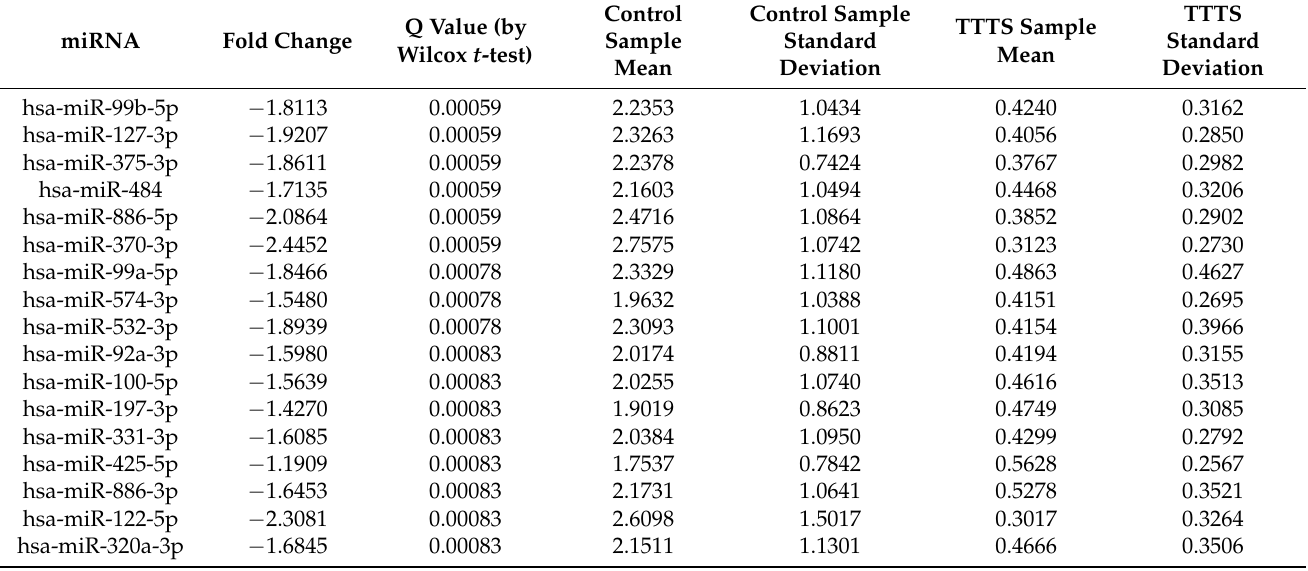
Figure 1. Heat map based on t -test from arrays separated TTTS subjects (red labels, n = 10) from controls (black labels, n = 10). Green indicates down-regulation; red, up-regulation. miRNAs in the right-hand column are ranked by t -test q-value. Table 2. Differentially expressed miRNAs by array.